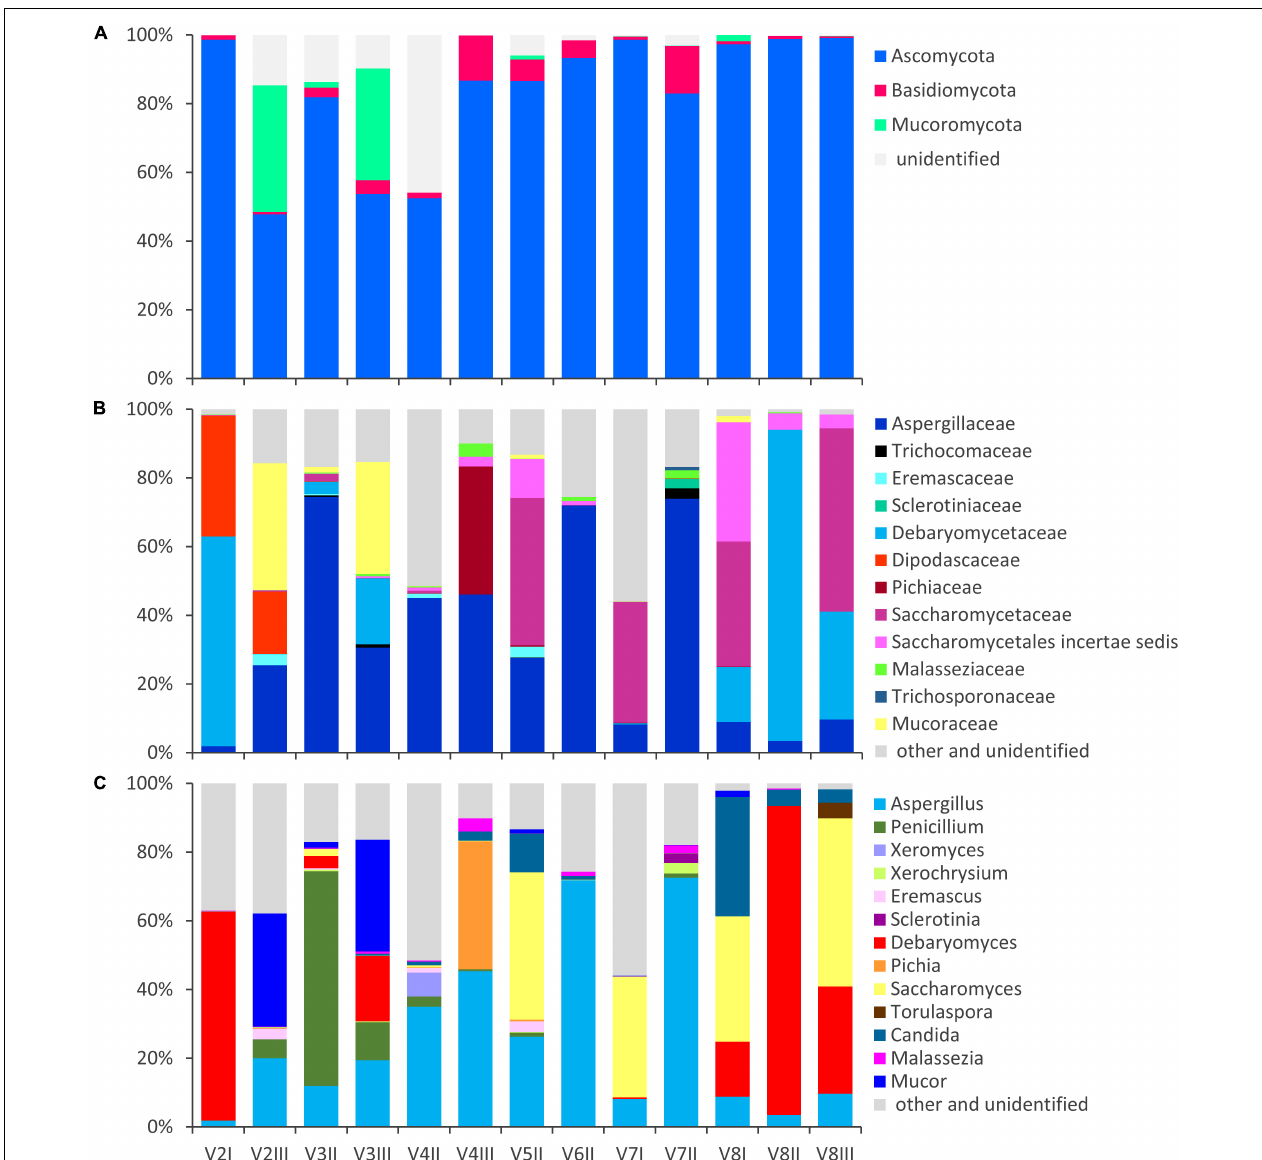
FIGURE 1 | Stacked bar-plot representation of the relative abundances of the main fungal taxa in the intestinal mycobiota, based on metagenomic ITS1 sequences. Only the taxa with a taxonomic attribution at the level of phylum (A) , family (B) , and genus (C) and appearing at least once with abundance higher than 1% are reported, all the others being grouped as “other and